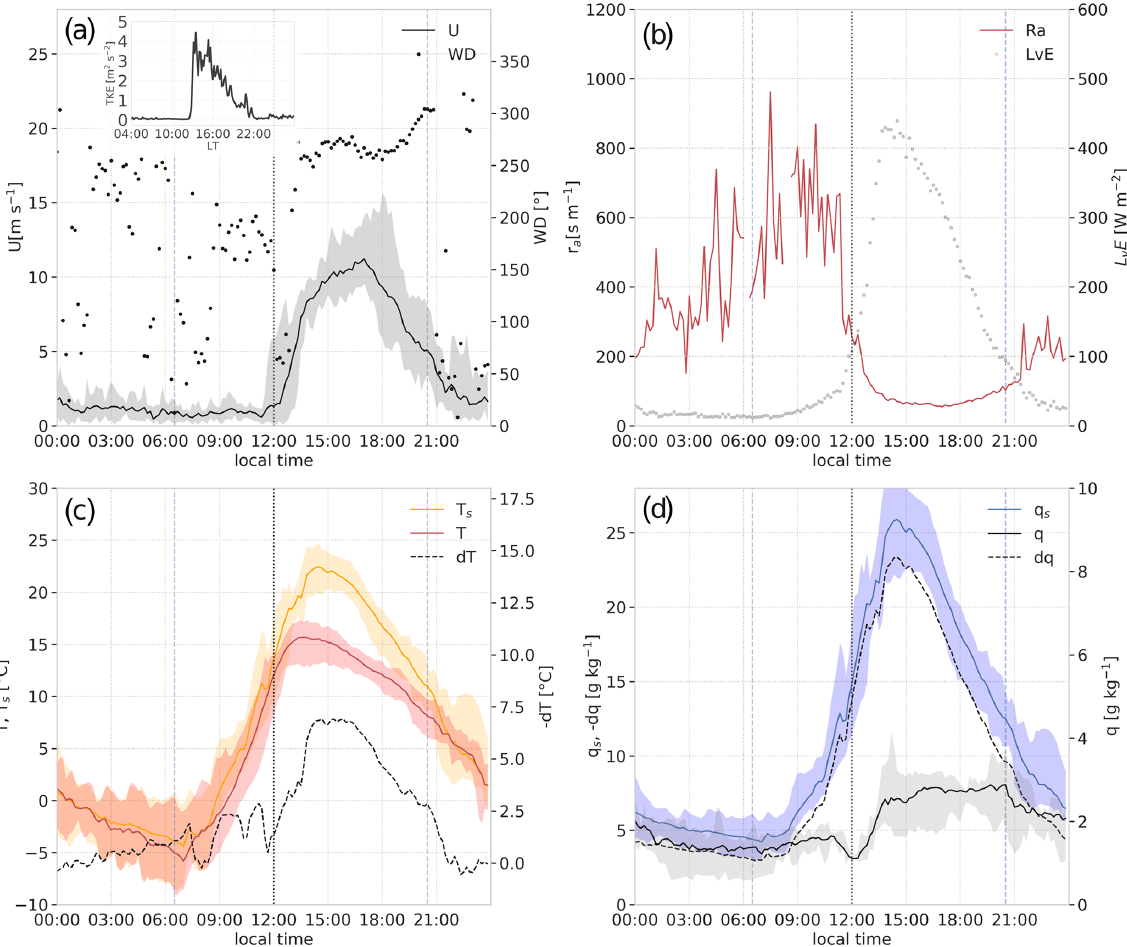
Figure 4. (a) Mean diurnal cycle of wind speed ( U ), turbulent kinetic energy (TKE) and wind direction (WD) of a representative day (18 November); (b) mean diurnal cycle of aerodynamic resistance ( r a ); (c) air temperature ( T ), surface temperature ( T s ) and thermal gradient ( − d T ); and (d) air specific humidity ( q ), surface saturated specific humidity ( q s ) and moisture gradient ( − d q ) observed over the water surface. Vertical dotted lines indicate the time of turbulent regime change, blue dashed lines the sunrise–sunset, and shadings represent maximum and minimum observations. Observations from 15–24 November